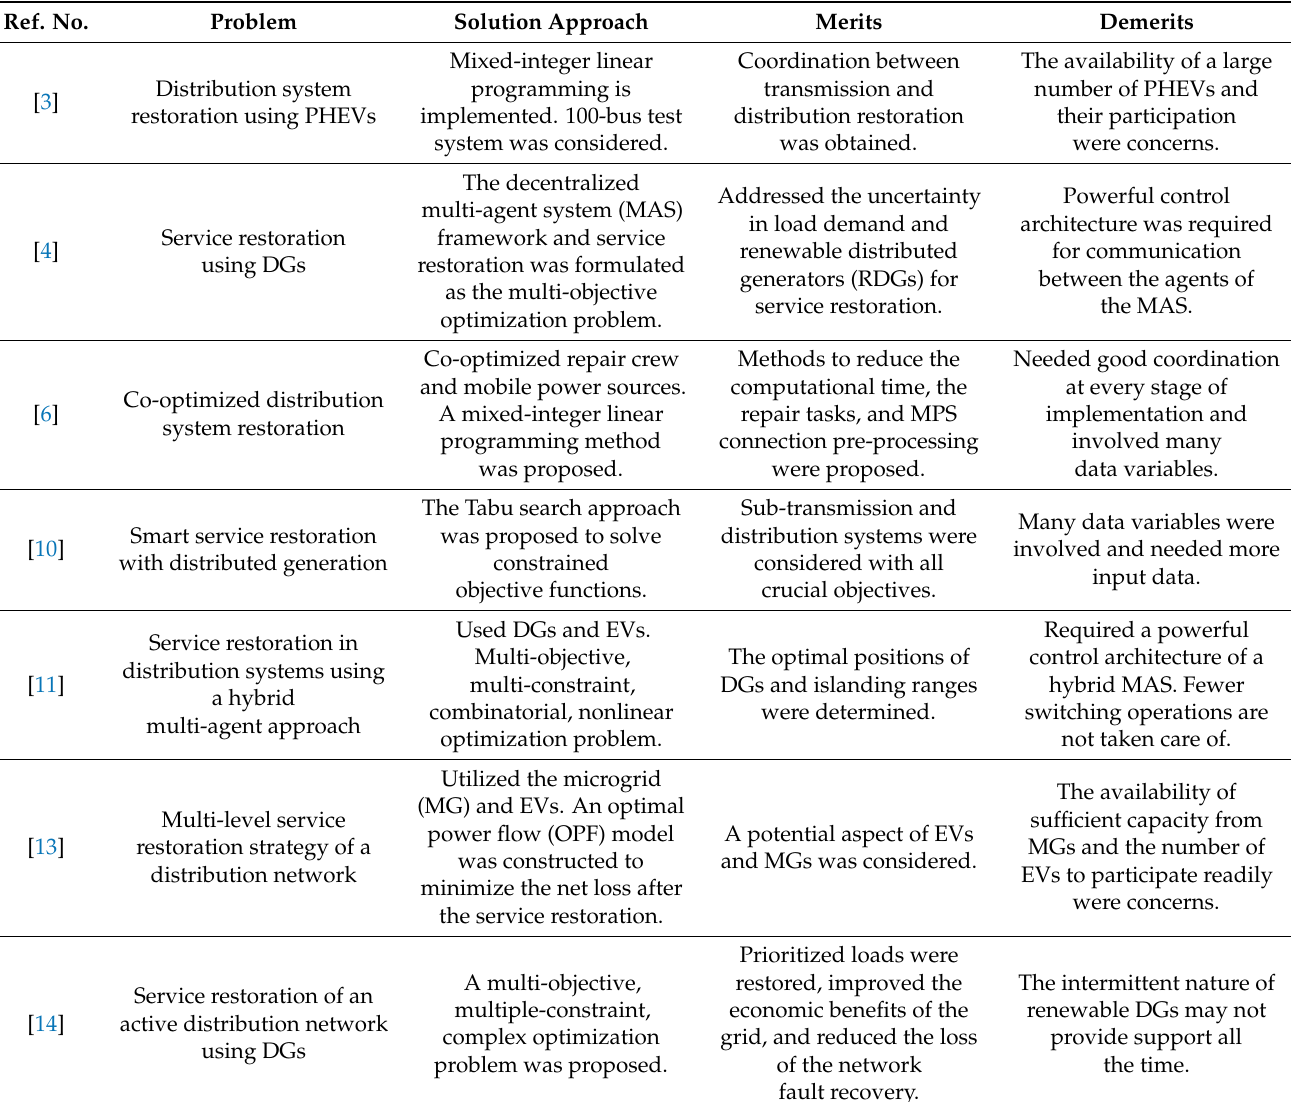
Table 1. Comparison of computational methods of service restoration in distribution